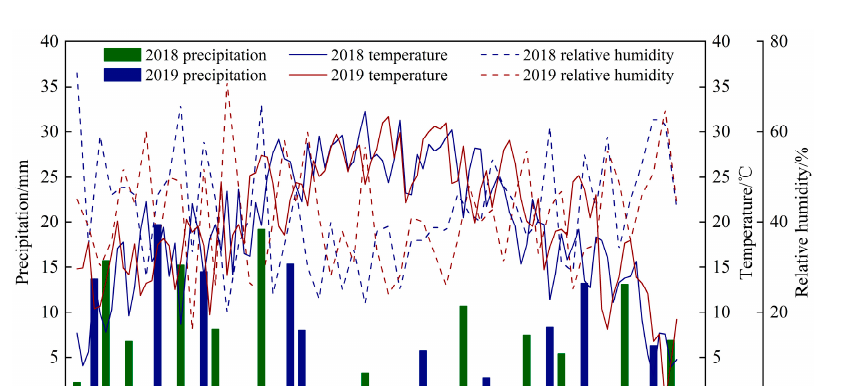
Figure 1. The experimental station’s location.